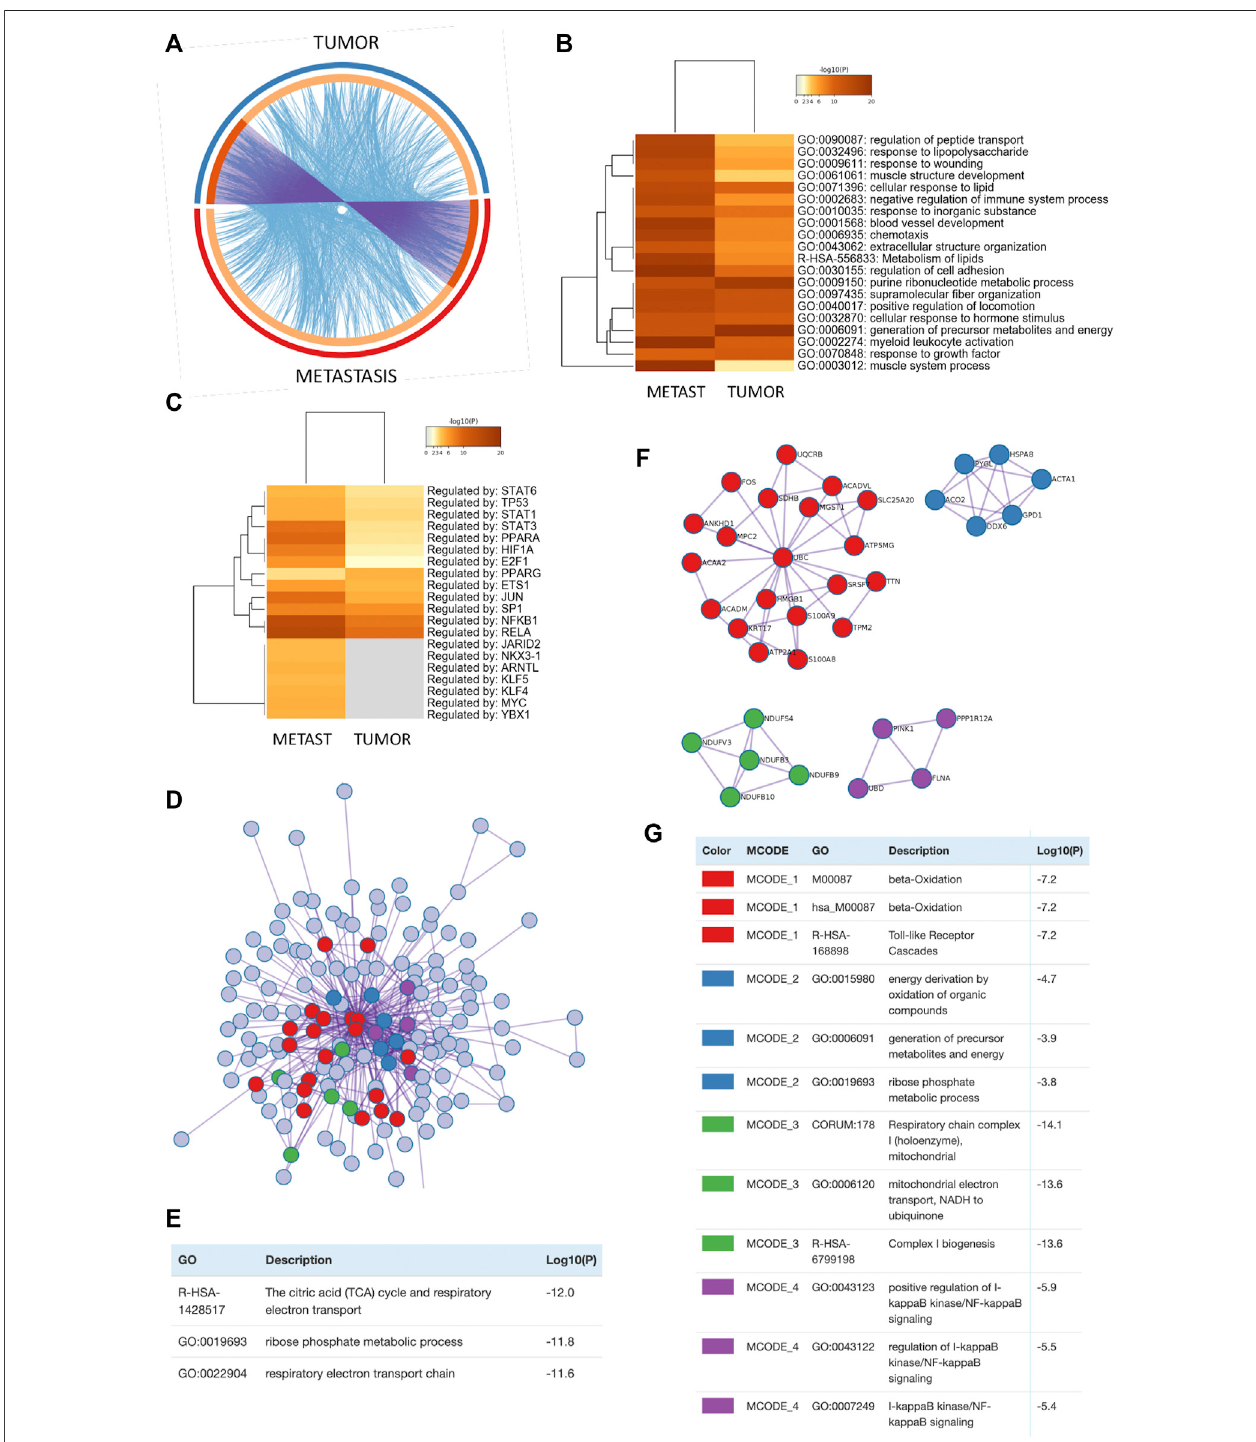
FIGURE 6 | Analysis of MGF regulated protein interaction network in colorectal cancer reveals key roles for mitochondrial energy metabolism and in fl ammatory signaling to mediate its anticancer effects (A) The Circos plot shows how genes from the different input gene lists of tumor (TUMOR) vs . metastasis (METAST) mouse models overlap. On the outside, arc represents the identity of each gene list. On the inside, orange color represents the gene names that appear in both lists and light orange color represent unique gene names that are part of common enriched pathways (same ontology term). Purple lines link the same gene shared by multiple gene lists. Blue lines link the genes where they fall into the same ontology term (the term has to be statistically signi fi cantly enriched). The greater the number of purple links and the longer the dark orange arcs implies greater overlap among the input gene lists. Blue links indicate the amount of functional overlap among the input gene